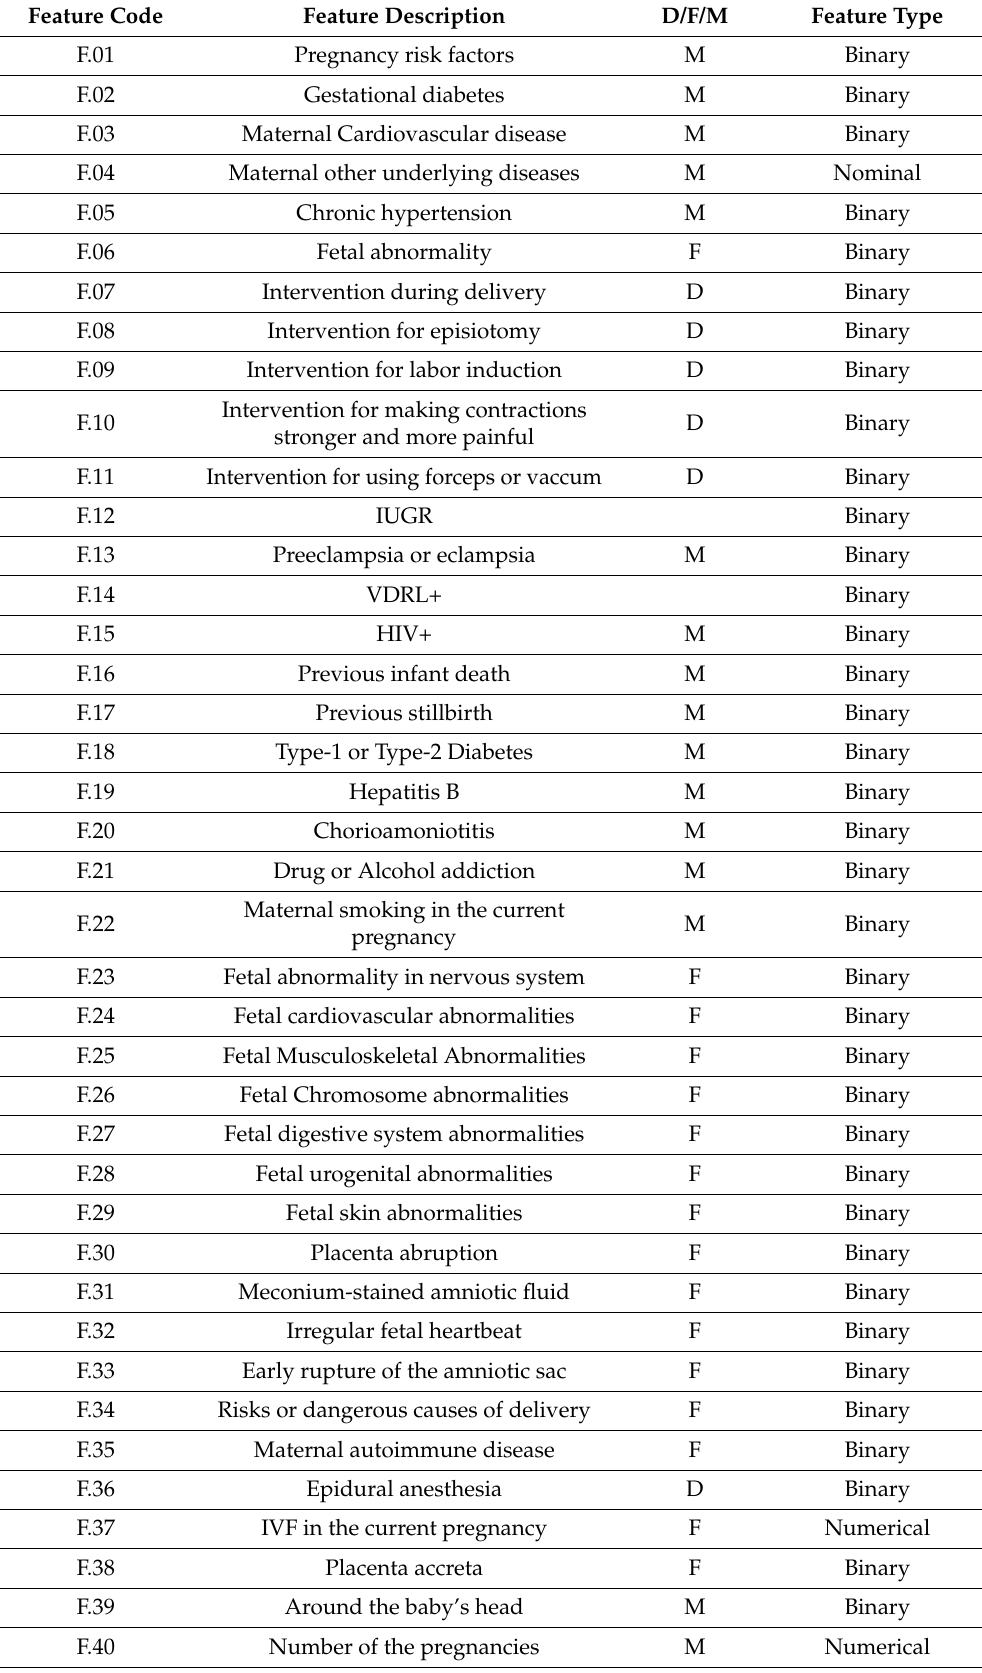
Table 1. Our data characteristics and